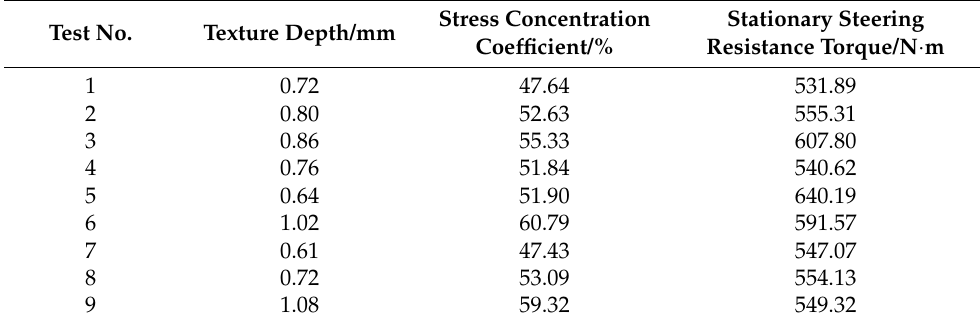
Table 5. Orthogonal test